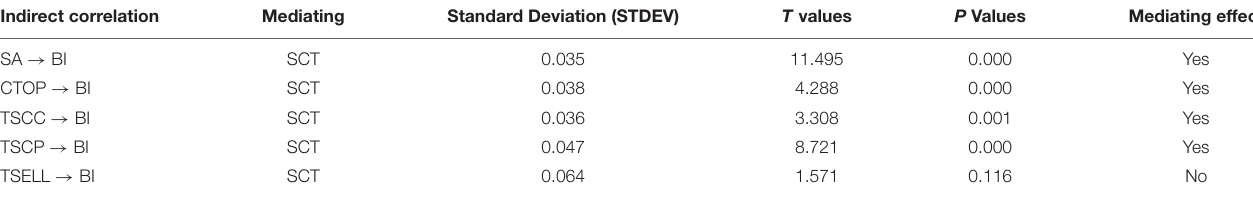
TABLE 7 | The mediating effects.